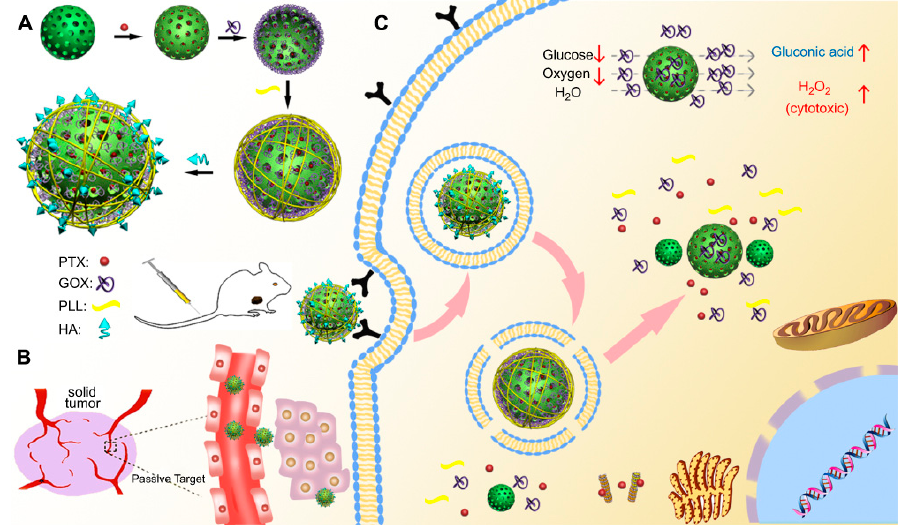
Figure 9. Schematic presentation of coated MSNs for synergistic tumor-targeted therapy [37].